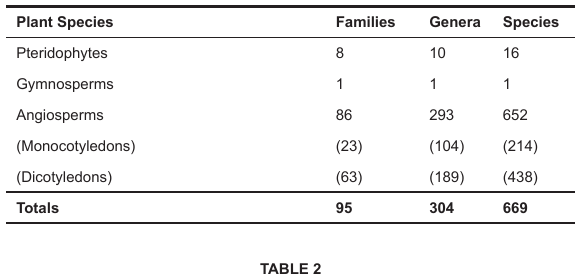
TABLE 2 Comprehensive list of Pteridophytes including 8 families, 10 genera and 16 species